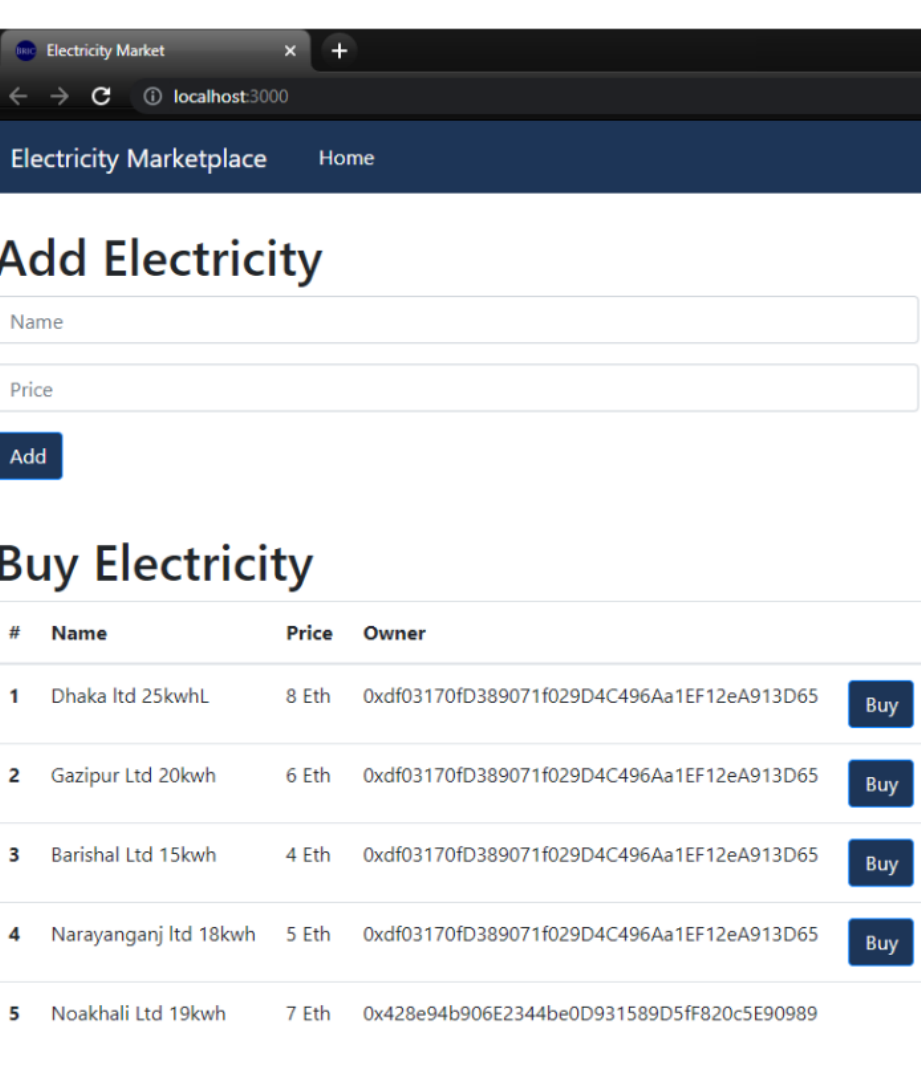
Figure 8. Front end application using